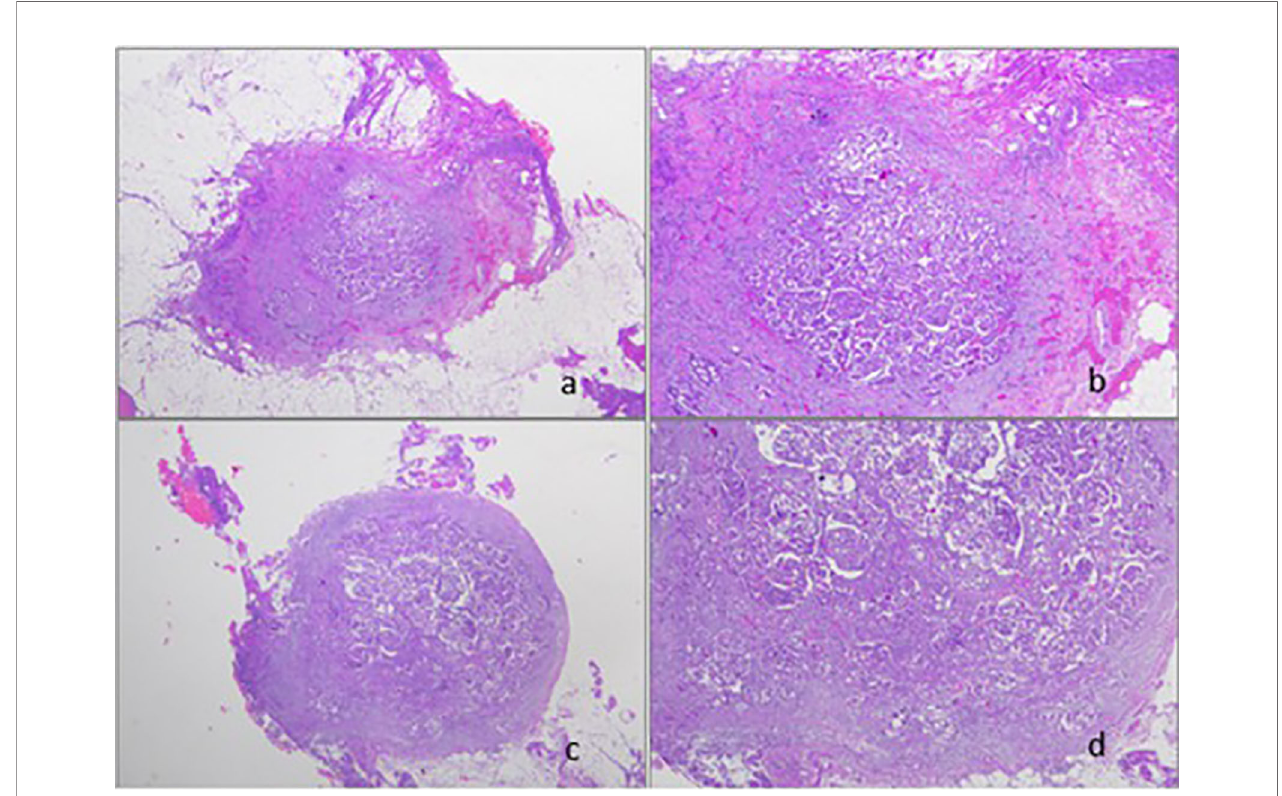
FIGURE 1 | (A, B) Peritoneal biopsy performed by standard electrosurgery stained by hematoxylin – eosin (original magni fi cation x 50 and x 200). (C, D) Peritoneal biopsy performed by J – plasma surgery stained by hematoxylin-eosin (original magni fi cation x 50 and x